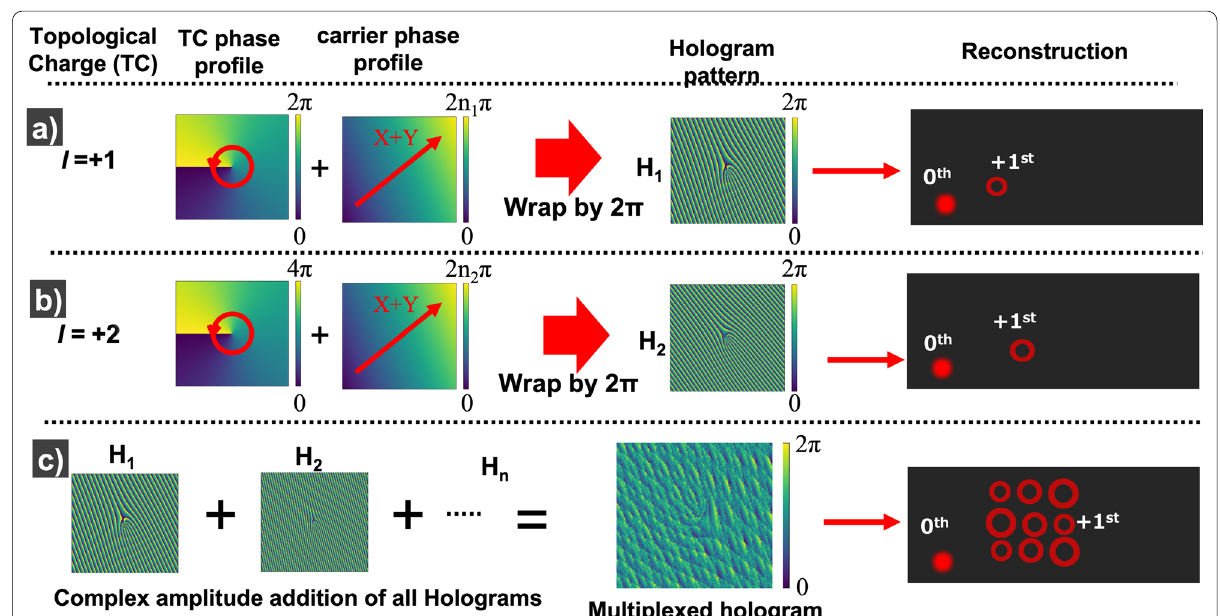
Fig. 4 a (left to right) The spiral phase profile corresponding to TC l = + 1 is added to a linear phase profile (carrier) and then wrapped by 2 π to generate the hologram pattern H 1 , which then reconstructs the optical vortex beam of TC l = + 1 , b the spiral phase corresponding to TC l = + 2 is added to a linear phase profile (carrier) and then wrapped by 2 π to compute the hologram pattern H 2 , which then reconstructs the optical vortex beam of TC l = + 2 , c The phases of holograms H 1 , H 2 , ... , H n are added together to generate the multiplexed hologram, which when